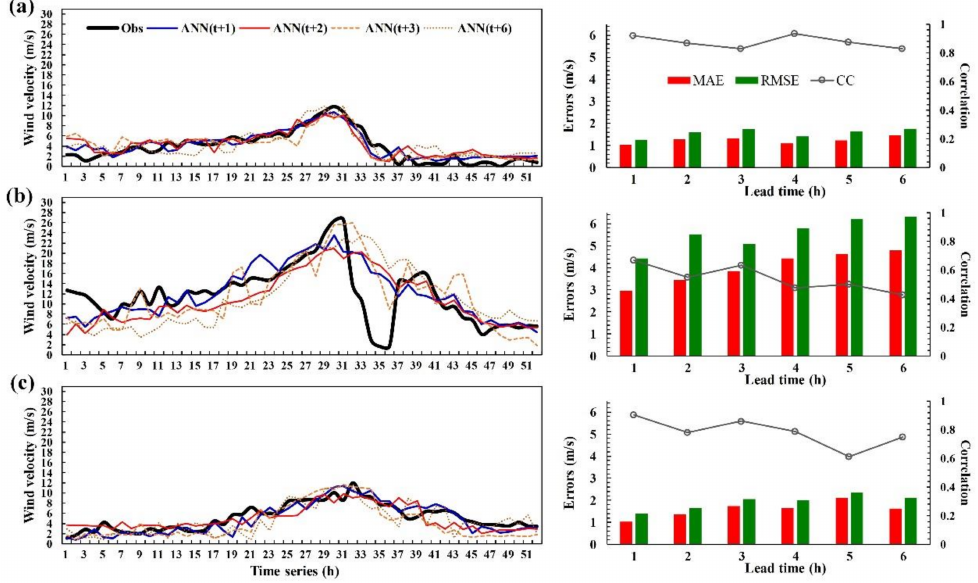
Figure 6. Comparisons between records and 1-6 h lead predictions for Dujuan in 2015: ( a ) Hsinchu, ( b ) Wuqi, and ( c ) Kaohsiung